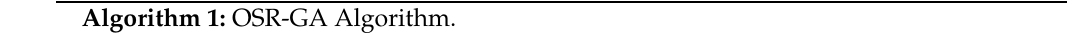
Algorithm 1: OSR-GA Algorithm.